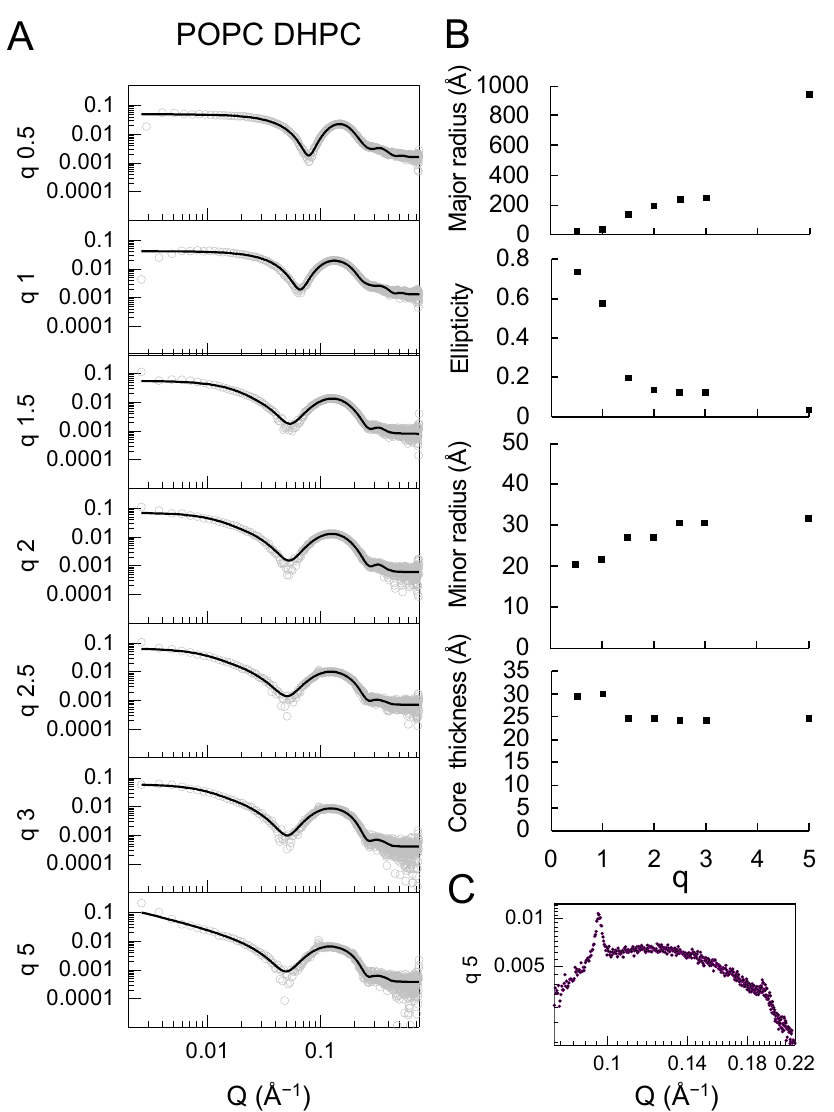
Figure 4. ( A ) SAXS curves (data points) and fit lines for bicelles composed of POPC and DHPC at 7 different q ratios. ( B ) Parameters derived from the SAXS fits. ( C ) Bragg peak in the SAXS curve for the POPC:DHPC mixture at q = 5.